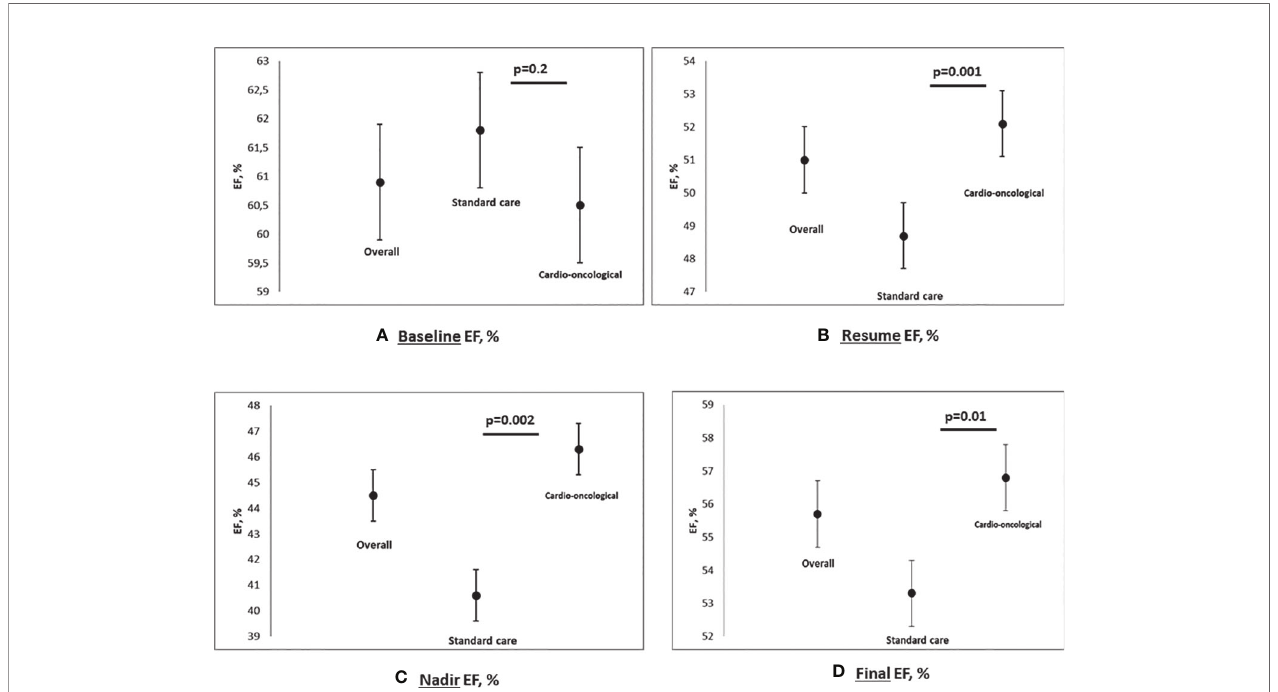
FIGURE 2 | Multipanel fi gure: scatter plot for EF baseline (A) , nadir (B) , resume (C) and fi nal (D) , % - Data are reported for overall population, standard care and cardioncological approach group (mean and SD, standard deviation; p